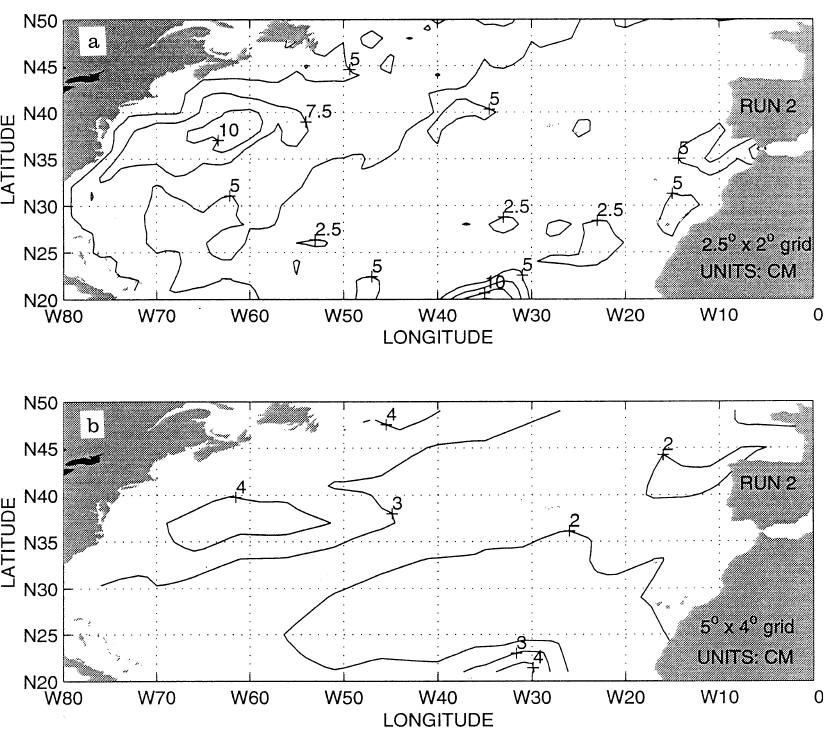
Fig. 8. a Uncertainty (cm) in the 2.5 (cid:176) (cid:180) 2 (cid:176) mean dynamic topography of Fig. 7a. b Uncertainty (cm) in the 5 (cid:176) (cid:180) 4 (cid:176) mean dynam- ic topography of